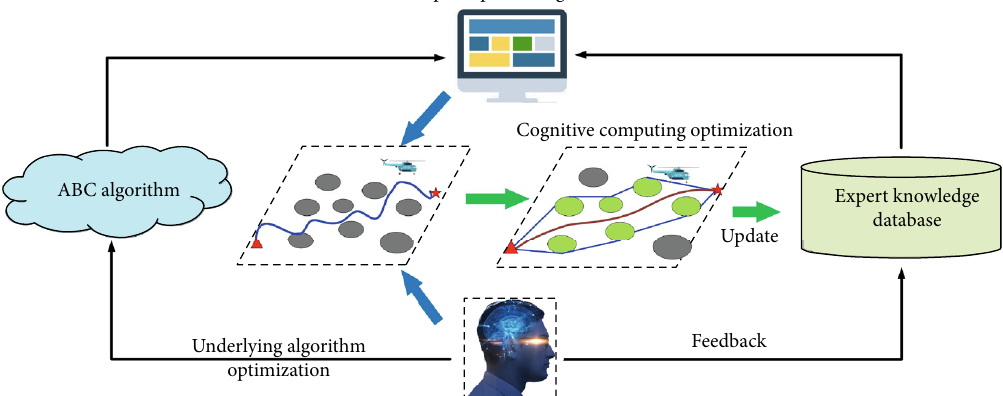
Figure 8: Diagram of human-computer collaboration.